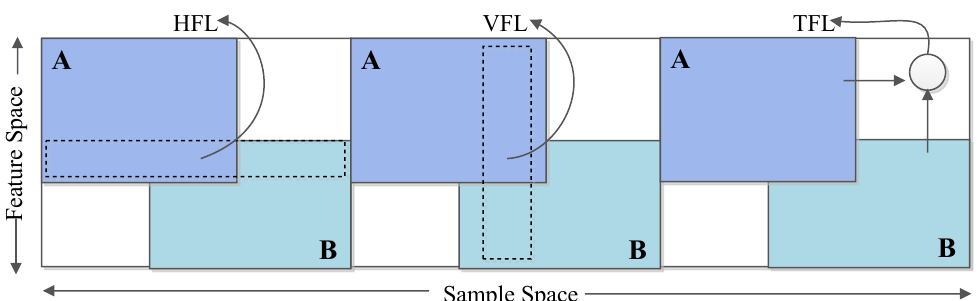
Figure 5. Categorization of FL based on Data Partition. Horizontal